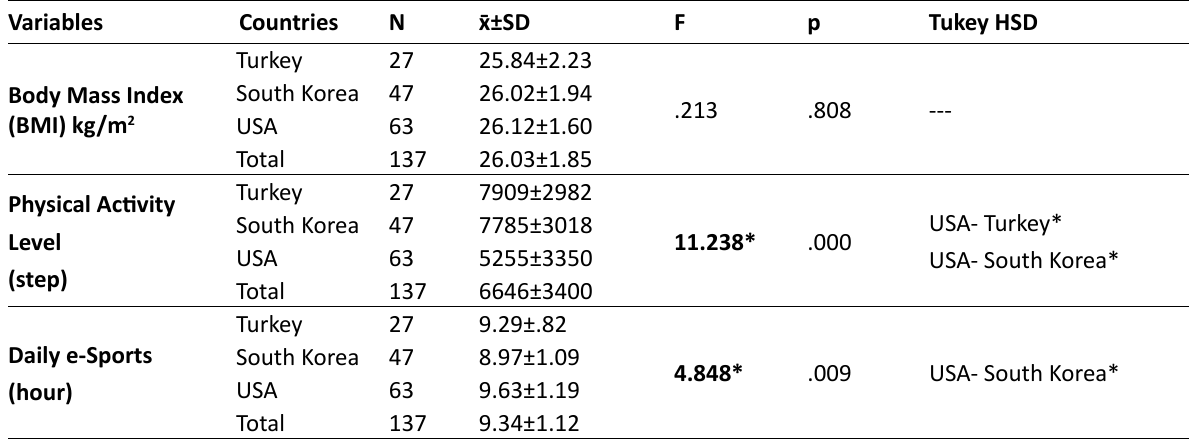
Table 2. Comparison of participants’ BMI, physical activity level and daily e-sports hours by country Variables